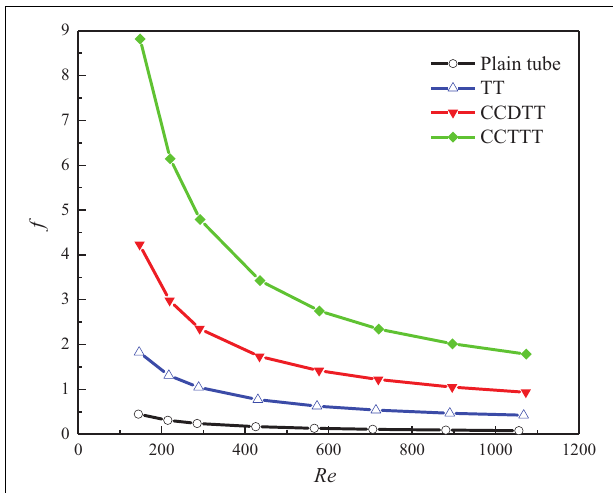
FIGURE 6 | The temperature profile of FLiBe in the plain tube and the tube fitted with TT, CCDTT, and CCTTT ( y = 3) at l = 0.24 m, Re =